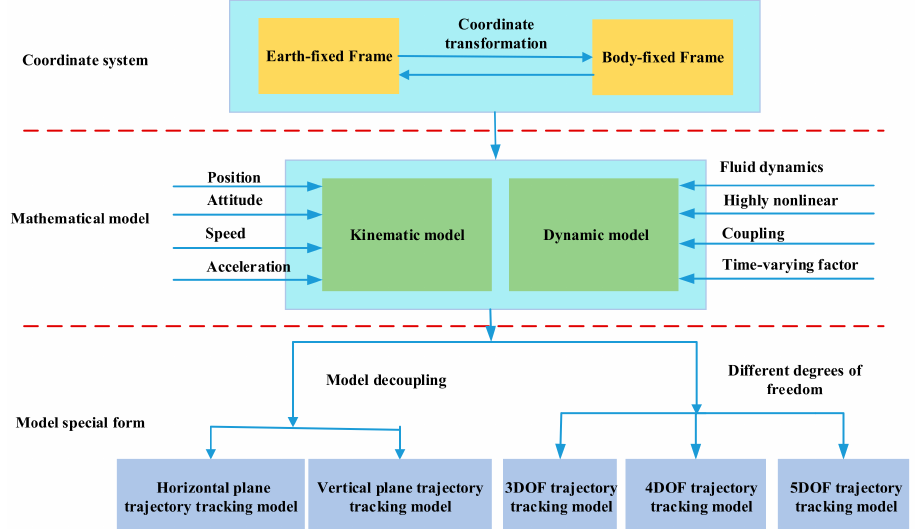
Figure 2. A block diagram of a model building system based on dynamic